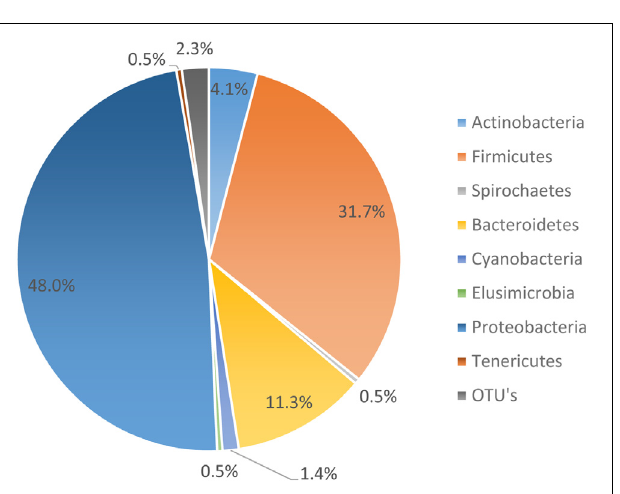
FIGURE 3 | All phylum present through rehang, pre-chill, and post-Chill.